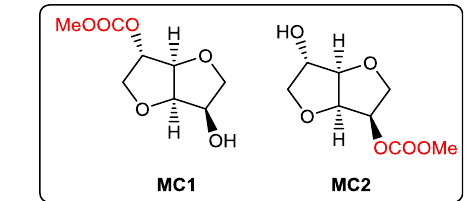
Table 2. Carboxymethylation of isosorbide. a # K 2 CO 3 (eq. mol.) Conv. (%)